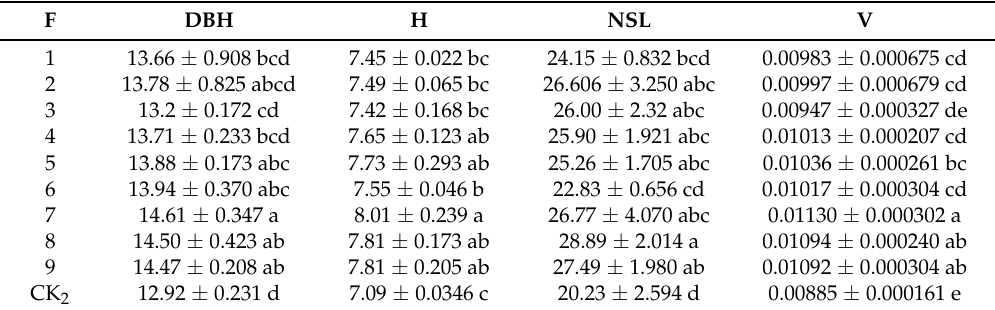
Table 3. Effects of two years in EXP.2 of combined N, P, and K fertilizer (F) on the diameter at breast height (DBH, cm), height (H, m), length of new shoots (NSL, cm), and trunk volume (V, m 3 ) of G. biloba in 2014 and 2015 in Yellow Sea Forest Park in